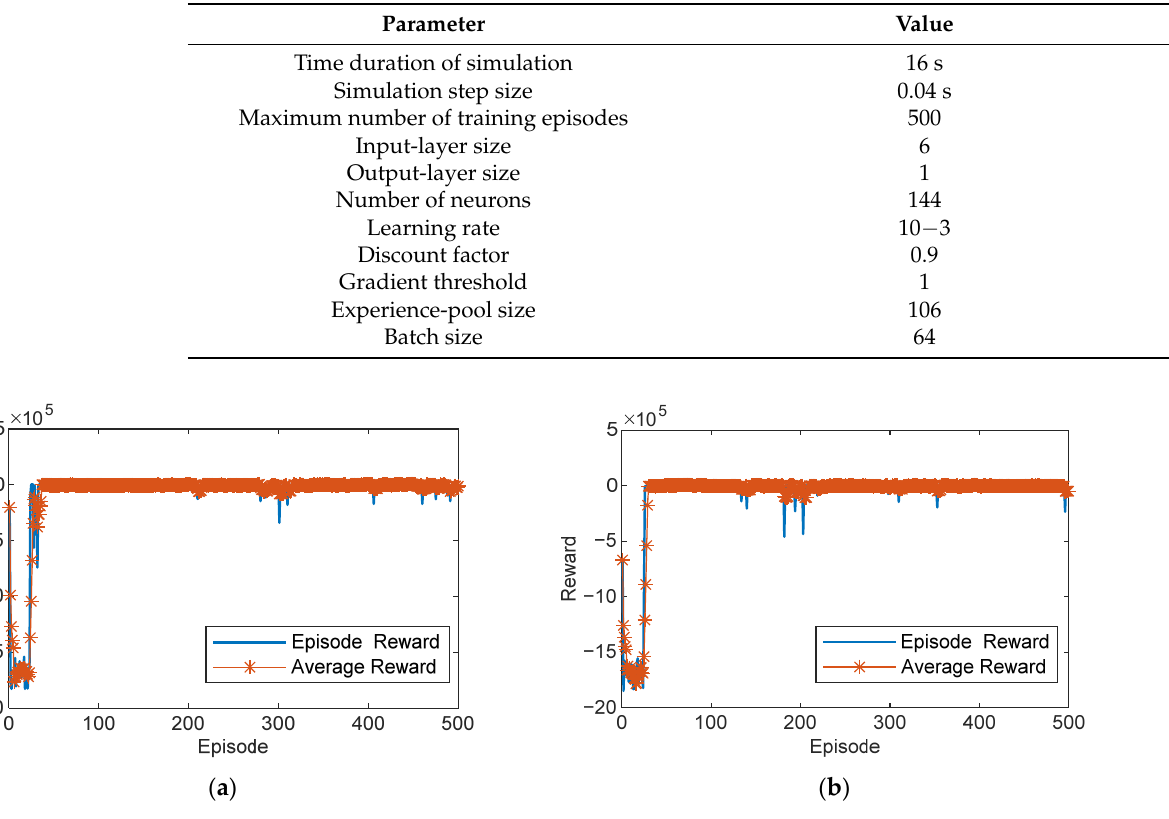
Figure 16. Reward convergence of training process under different conditions: ( a ) condition I and ( b ) condition II.